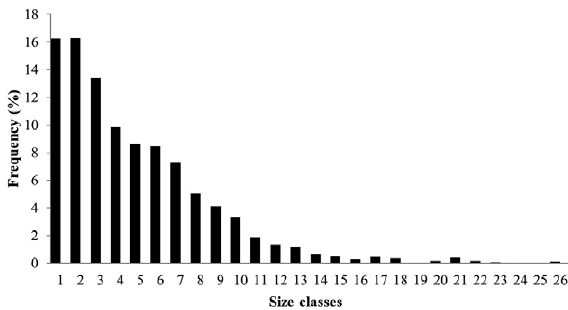
Fig. 4. – Density-frequency distributions of Cystoseira s.l. species (n=2885).